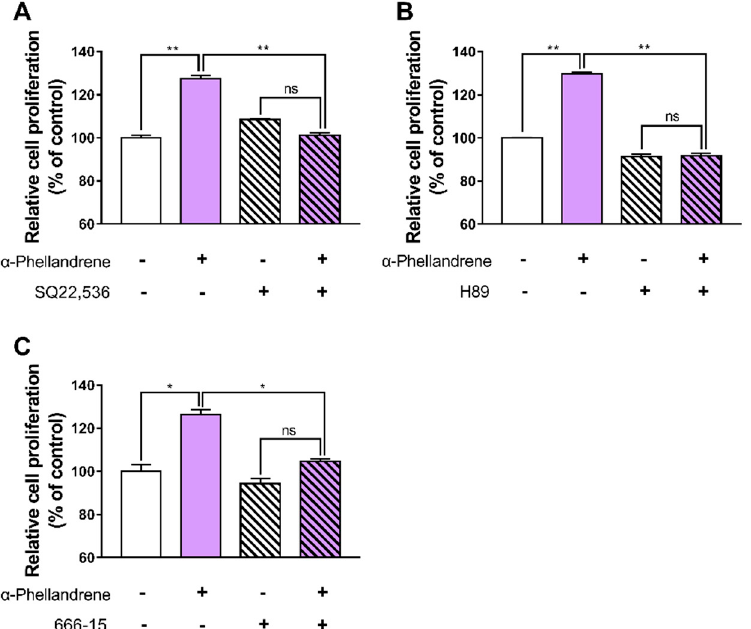
Figure 4. α -phellandrene promotes cell proliferation via the cyclic adenosine monophosphate (cAMP) signaling pathway. Cells were incubated with either vehicle (dimethyl sulfoxide; DMSO) or 12.5 µ M of α -phellandrene for 48 h. The cells were preincubated with the vehicle, 50 µ M of SQ22,536, 10 µ M of H89 (protein kinase A inhibitor), or 100 nM of 666-15 (cAMP-responsive element-binding protein inhibitor) for 1 h before α -phellandrene treatment. ( A – C ) Cell proliferation was measured using water-soluble tetrazolium salt (WST-1) analysis. Results are expressed as mean ± standard error of the mean (SEM) of three independent experiments. Statistically significant differences are marked as ns, not significant ( p > 0.05); * p < 0.05; ** p < 0.01.